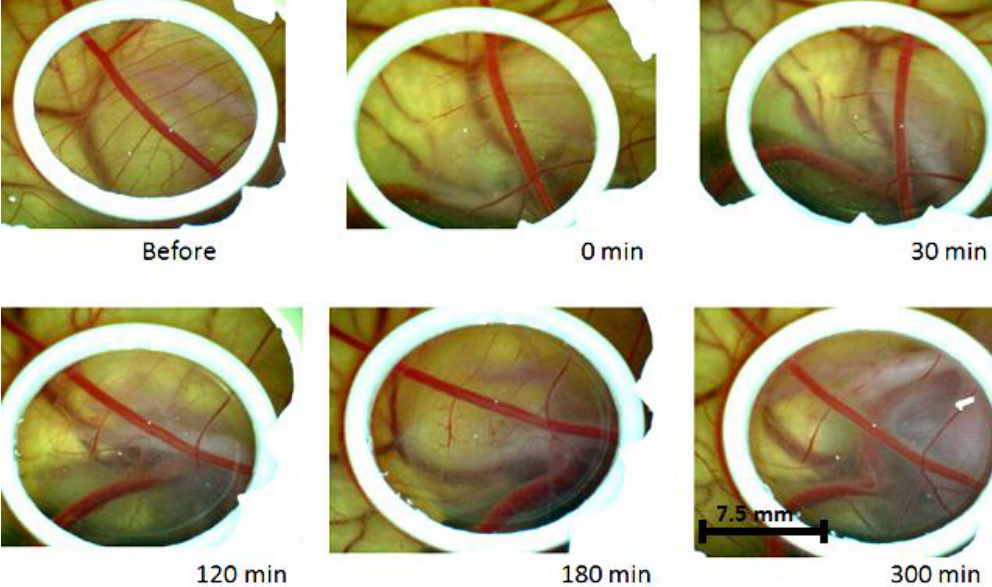
Figure 3. Photodynamic therapy (PDT) response with curcumin concentration that 0.1 mM over the time with total dose of 30 J/cm².